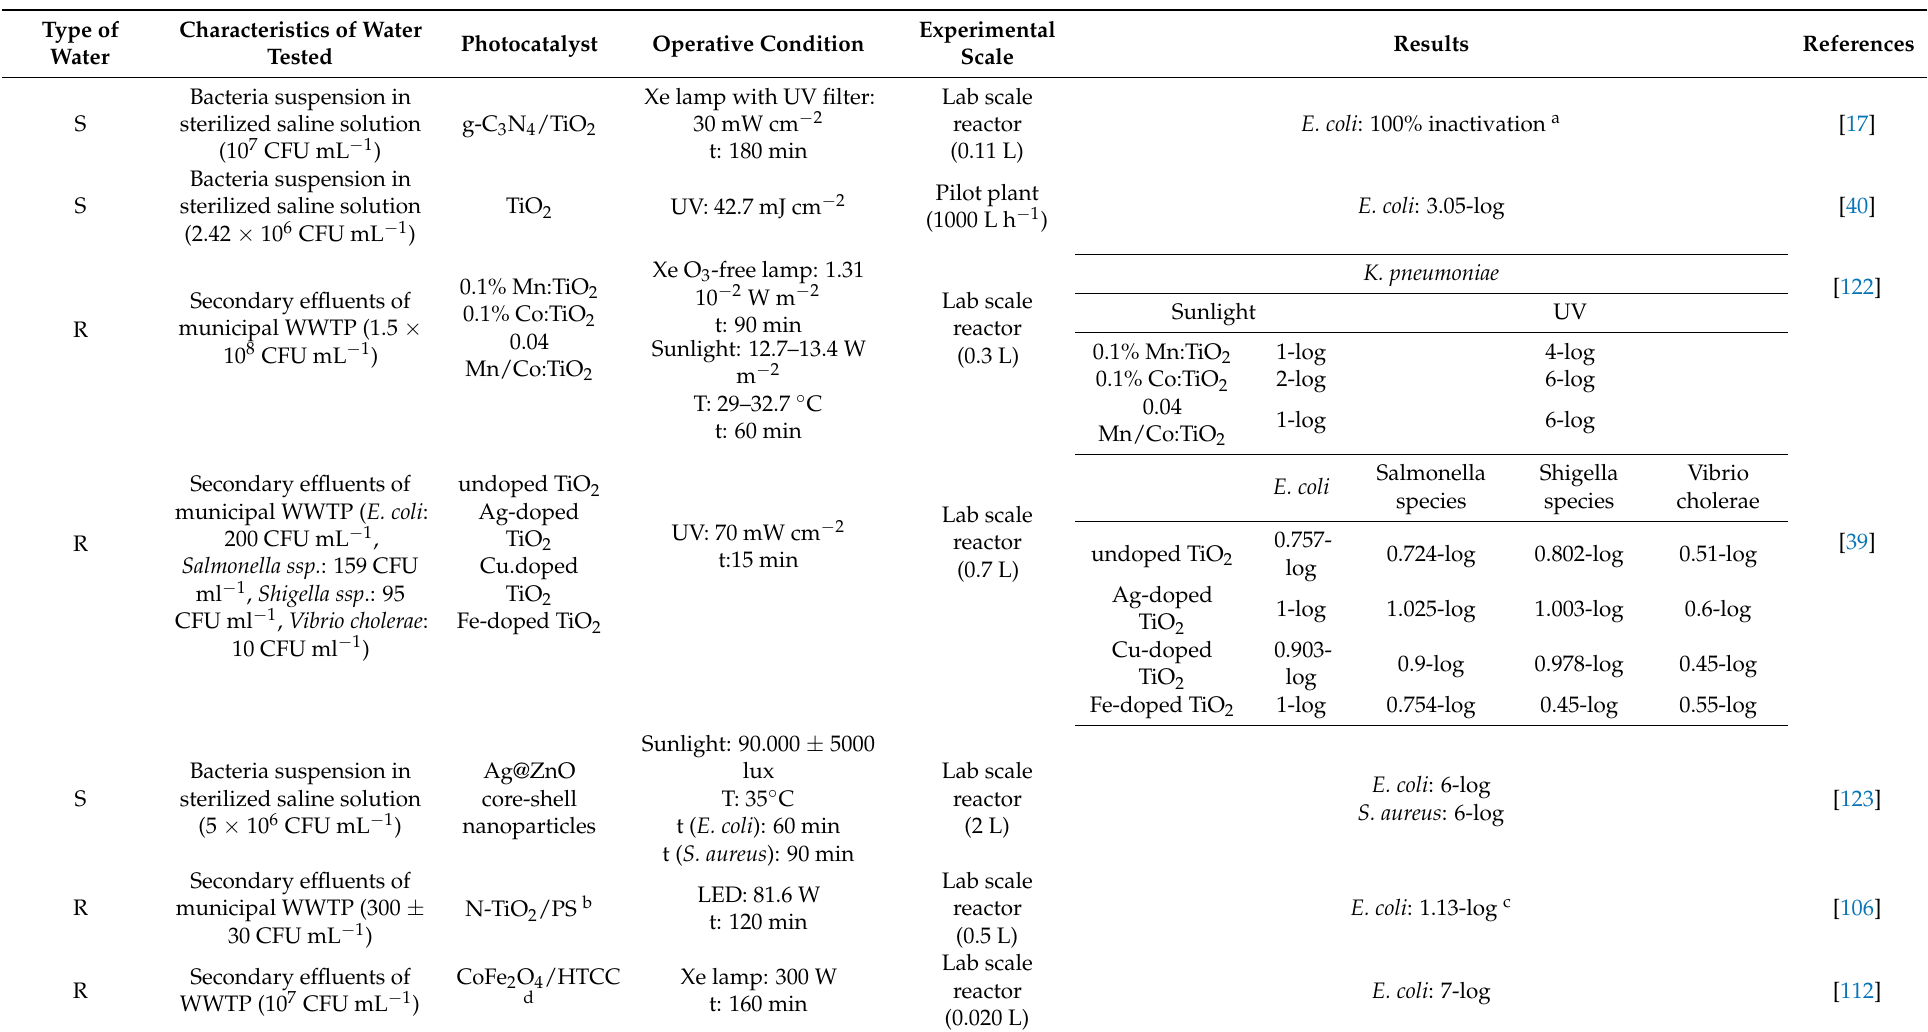
Table 4. Several results of PC disinfection tests. S: synthetic water, R: real water, UV: ultraviolet radiation, t: contact